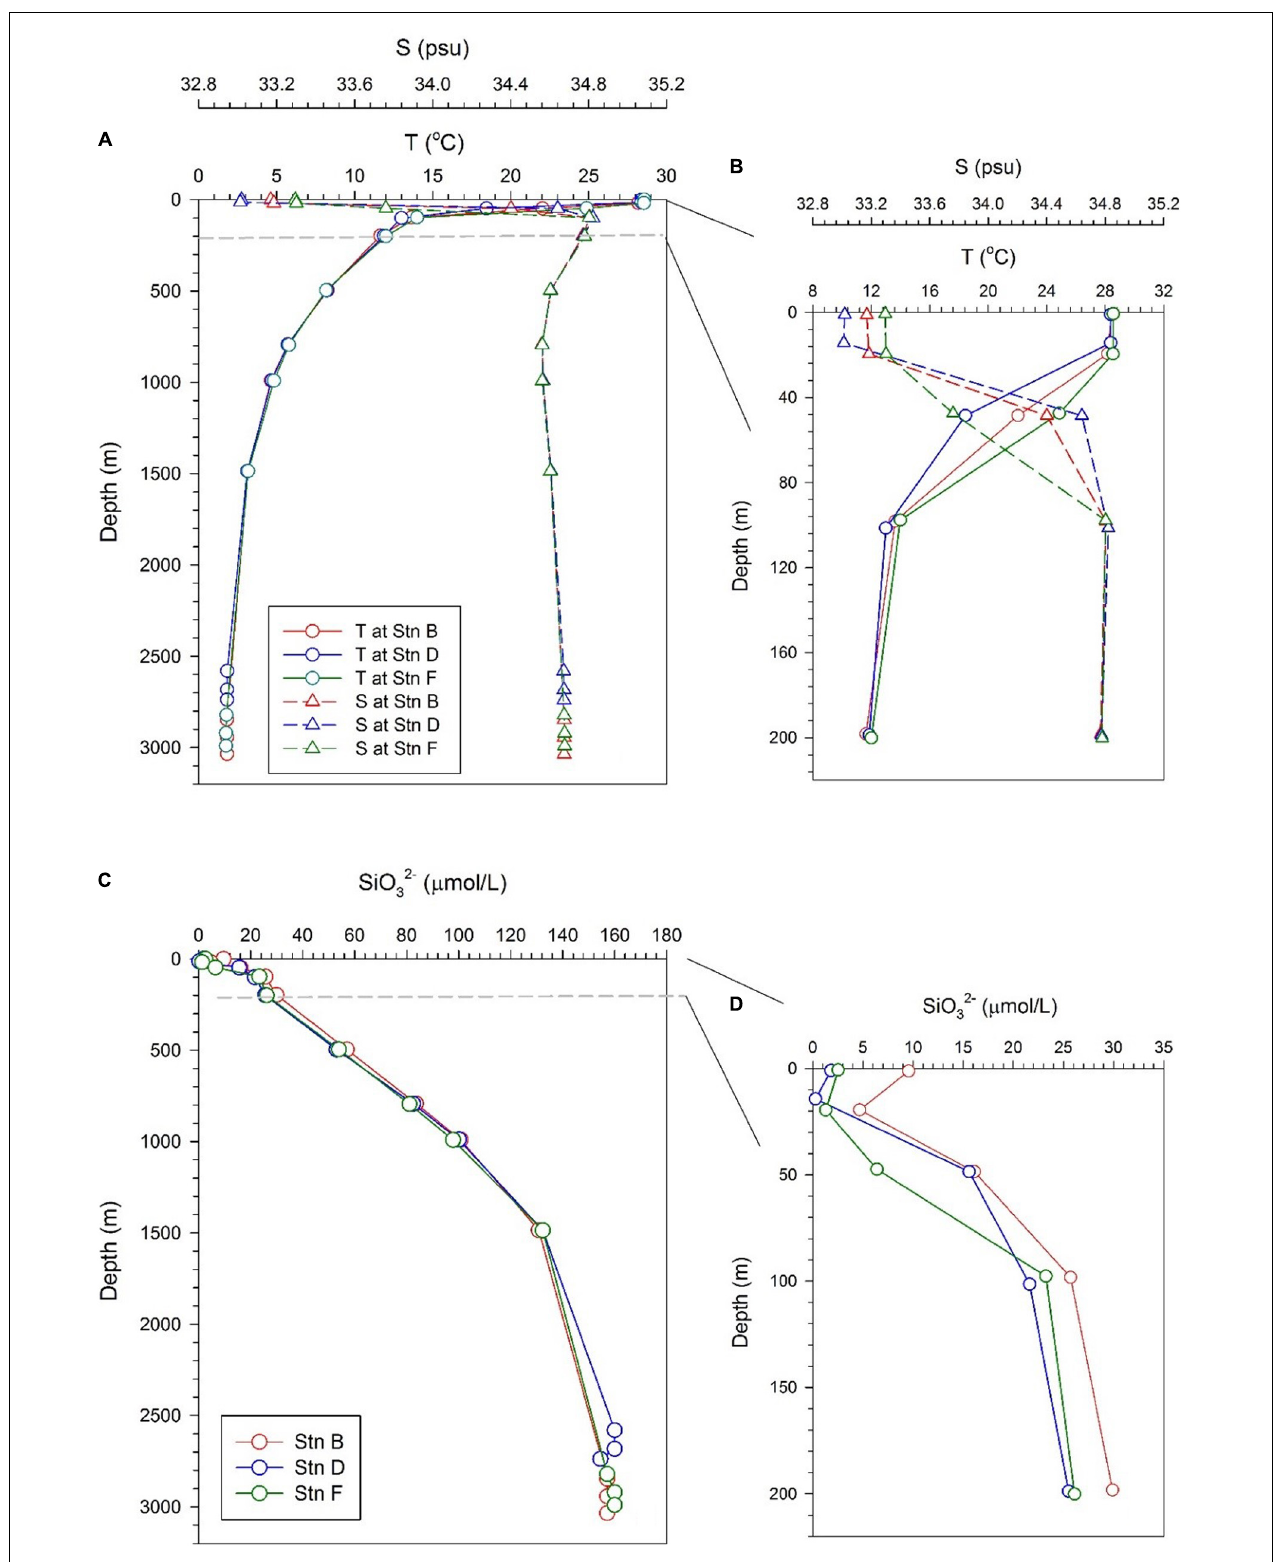
FIGURE 2 | Profiles of temperature, salinity, and silicate at the three sites; panels (A,B) are profiles of temperature and salinity in the full water column and the upper 200 m, respectively; panels (C,D) are the profile of silicate in the full water column and the upper 200 m, respectively.